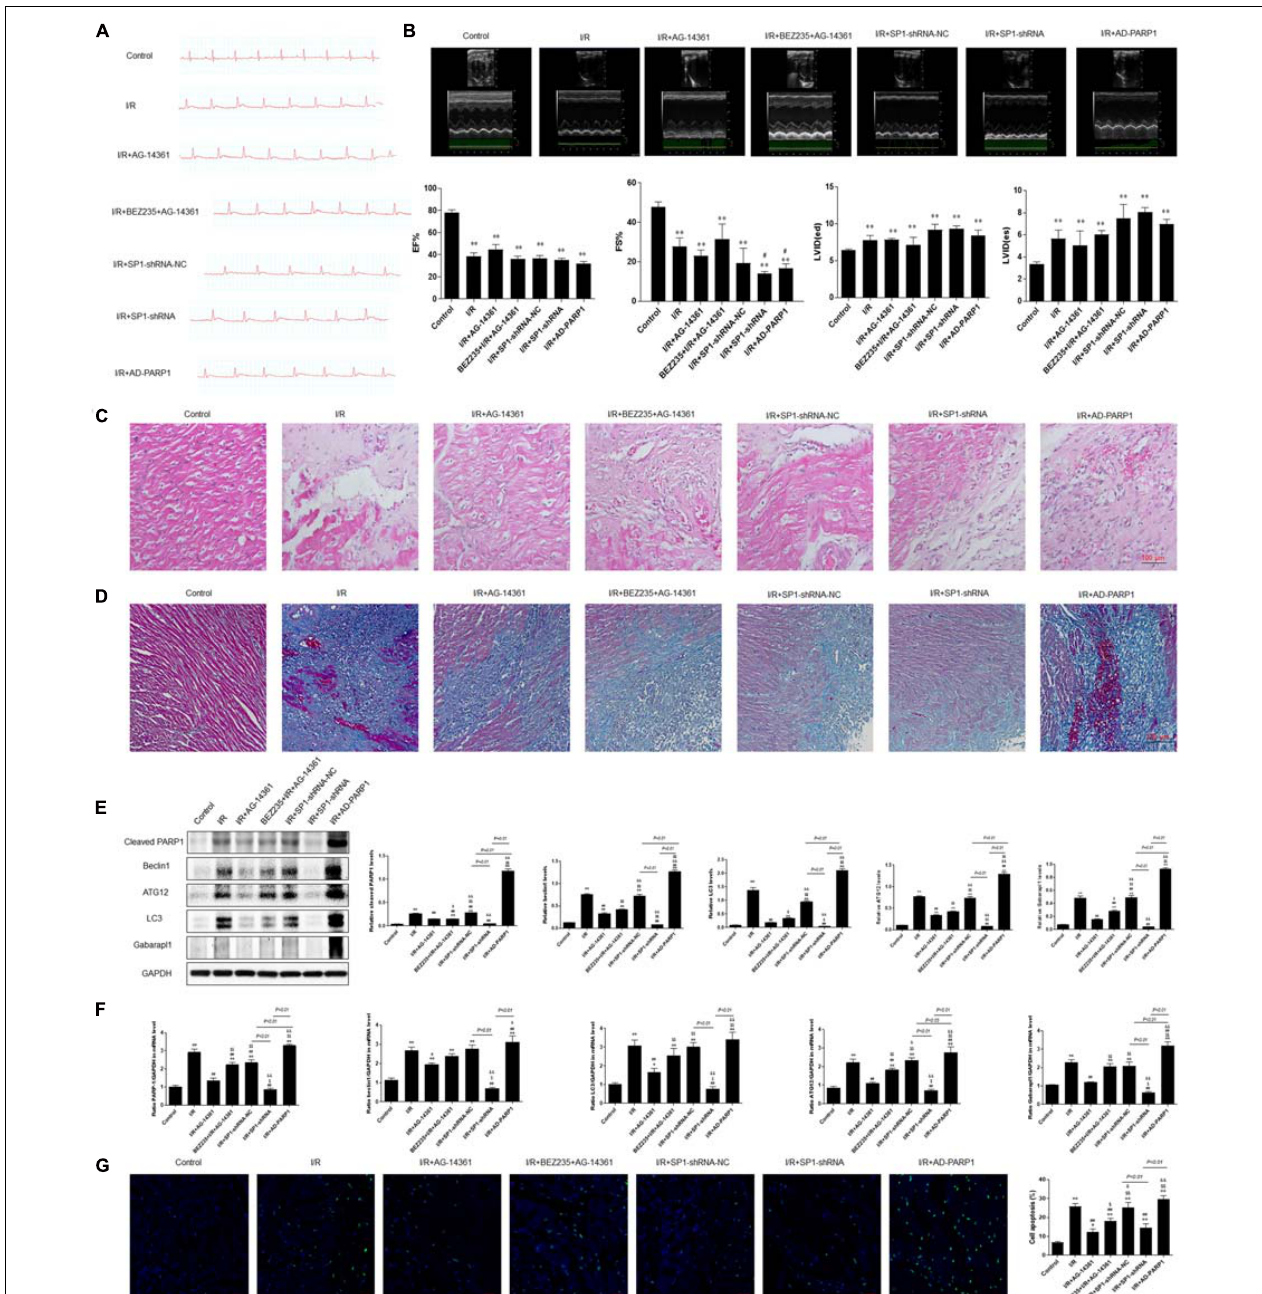
FIGURE 6 | PARP1 inhibition protected cardiomyocytes from MIRI in vivo via inhibition of autophagy, which is targeted by Sp1 suppression. An MIRI rat model was established by 45 min of ischemia via ligating left anterior descending branch (LAD), and then refused for 24 h. MIRI-modeled SD rats were treated with Sp1 shRNA-NC, Sp1 shRNA, PARP1 inhibitor AG-14361 and AD-PARP1 adenovirus. (A) Electrocardiogram showed the ST-segment variation of SD rats when treated with Sp1 shRNA-NC, Sp1 shRNA, PARP1 inhibitor AG-14361 and AD-PARP1 adenovirus under MRI model. (B) Echocardiography showed the different left ventricular ejection fraction (LVEF%) and fractional shortening (FS%) of SD rats when treated with Sp1 shRNA-NC, Sp1 shRNA, PARP1 inhibitor AG-14361 and AD-PARP1 adenovirus under MIRI model. (C,D) Hematoxylin and eosin (H&E) and Masson trichrome staining were performed to assess myocardial fibrosis of SD rats when treated with Sp1 shRNA-NC, Sp1 shRNA, PARP1 inhibitor AG-14361 and AD-PARP1 adenovirus under MIRI model. Magnification: 100 × . (E) Western blot analysis showed the expression of PARP1 and autophagy-related proteins of SD rats when treated with Sp1 shRNA-NC, Sp1 shRNA, PARP1 inhibitor AG-14361 and AD-PARP1 adenovirus under MIRI model. (F) Real-time PCR analysis showed the mRNA expression of PARP1 and autophagy-related proteins of SD rats when treated with Sp1 shRNA-NC, Sp1 shRNA, PARP1 inhibitor AG-14361 and AD-PARP1 adenovirus under MIRI model. (G) TUNEL assay showed the different apoptotic rate of SD rats when treated with Sp1 shRNA-NC, Sp1 shRNA, PARP1 inhibitor AG-14361 and AD-PARP1 adenovirus under MIRI model. Magnification: 100 × . Compared with control group, * P < 0.05, ** P < 0.01; compared with OGD/R group, # P < 0.05, ## P < 0.01; compared with OGD/R+AG-14361 group, $ P < 0.05, $$ P < 0.01; compared with BEZ235+OGD/R+AG-14361 group, & P < 0.05, && P < 0.01. N = 4 for each group.